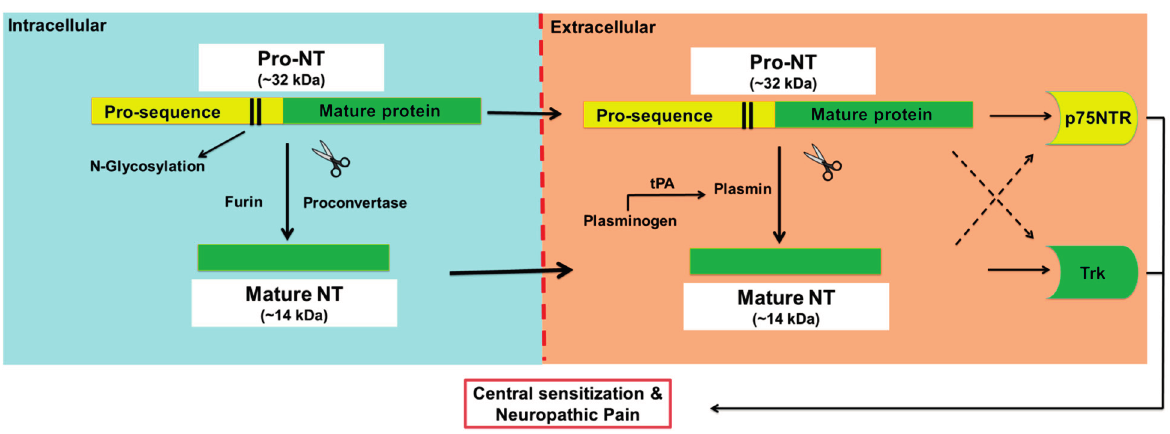
Figure 1. Proteolytic cleavage of pro-neurotrophins to mature neurotrophins.